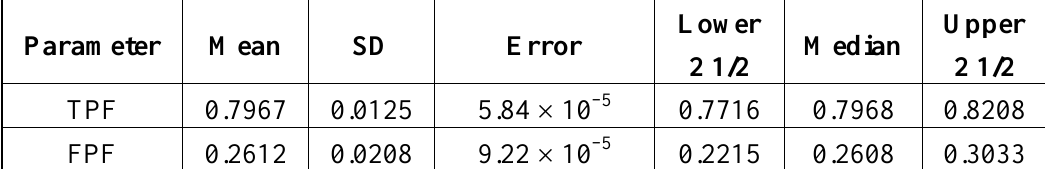
Table 3. Posterior distribution of the true and false positive